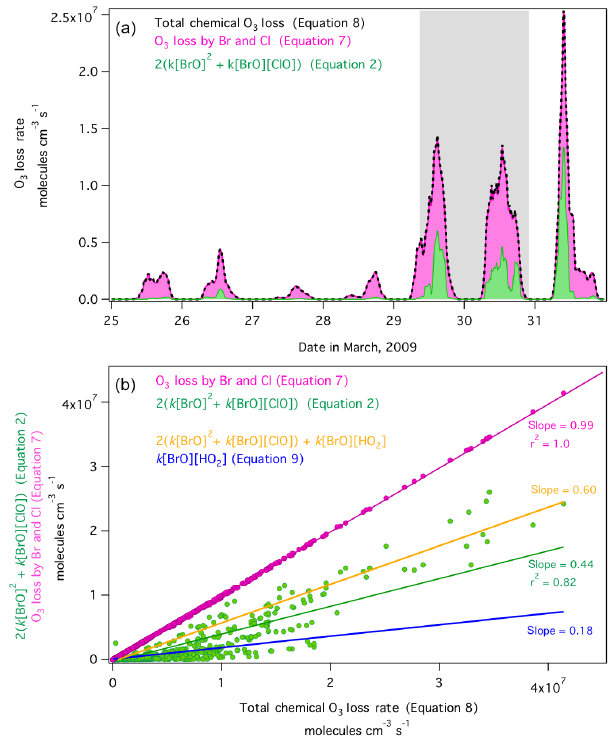
Figure 9. (a) Comparison of the time-varying O 3 loss rate cal- culated using the estimation of 2 (k [ BrO ] 2 + k [ BrO ][ ClO ] ) (Eq. 2, green), the simulated O 3 loss rate by Br and Cl (Eq. 7, pink), and the total simulated chemical O 3 loss rate (Eq. 8, dashed black trace). Model output is smoothed by hourly averaging. The grey-shaded box represents a period of missing Br 2 observations. Time is ex- pressed in Alaska standard time. (b) Shown is a regression of the 2 (k [ BrO ] 2 +[ BrO ][ ClO ] ) estimation method (Eq. 2) versus the to- tal simulated chemical O 3 loss rate in the base model (Eq. 8) in the green data, and a regression of O 3 loss rate by Br and Cl only (Eq. 7) versus the total simulated chemical O 3 loss rate in the pink data. The blue trace represents the O 3 loss rate estimated by only con- sidering k [BrO][HO 2 ] (Eq. 9). The orange trace estimates O 3 loss rate combining the three major gas-phase ozone depletion cycles. The slopes represent the fraction of the chemical O 3 loss rate that can be accounted for by each method. For the conditions simulated, the commonly used estimation method of 2 (k [ BrO ] 2 +[ BrO ][ ClO ] ) only accounts for 44% of the chemical O 3 loss